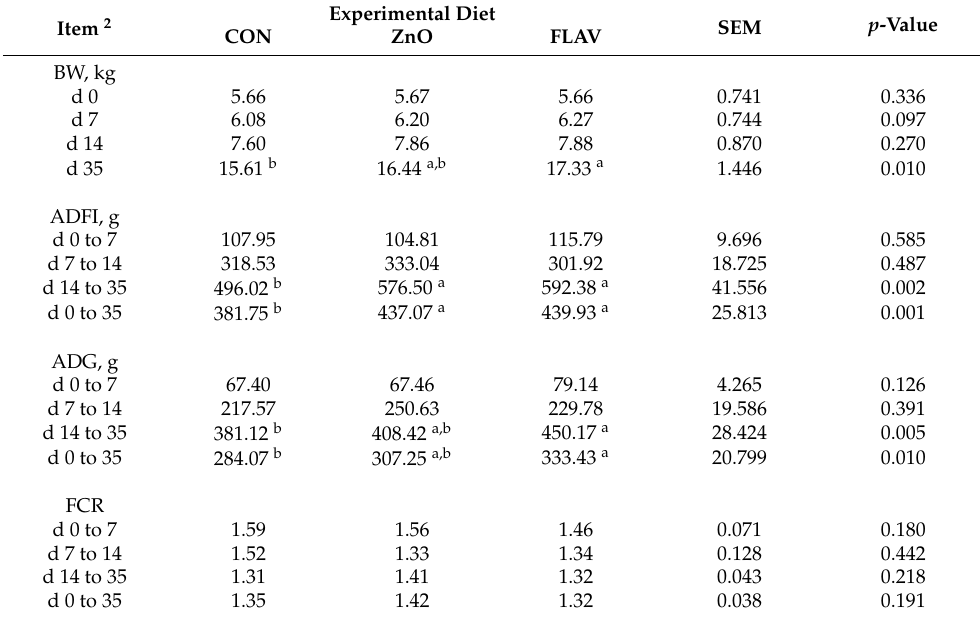
Table 2. Effect of experimental diets on growth performance of weaned pigs 1